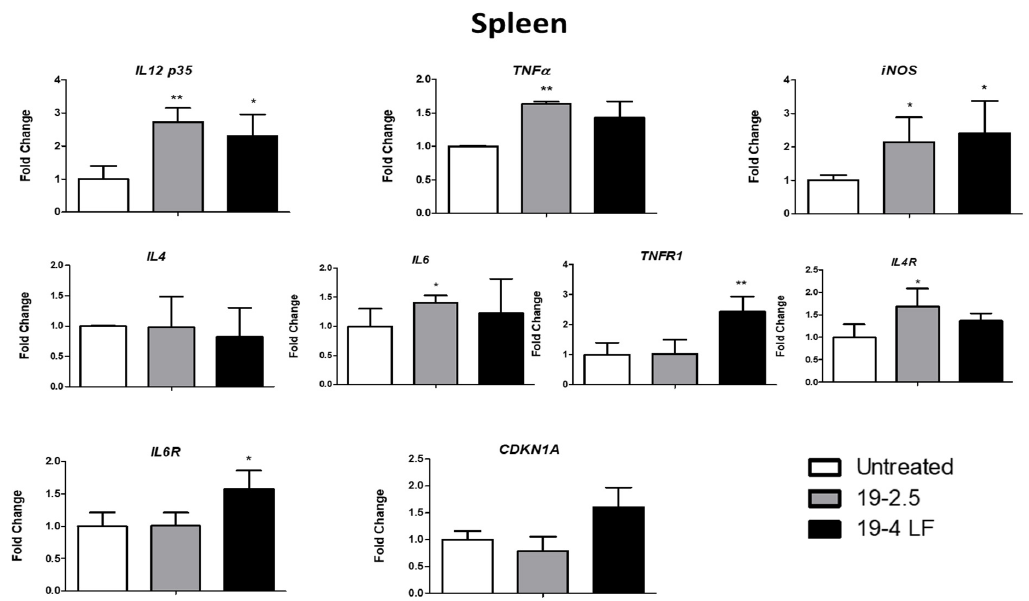
Figure 5. Gene expression levels of Th1 cytokines ( IL 12 p35 and TNF α ), iNOS gene, Th2 cytokines ( IL 4 and IL 6 ), cytokine receptors ( TNFR1 , IL4 R α and IL6 R ) and CDKN1A gene from the spleen of BALB/c mice treated with 19-2.5 and 19-4 LF peptides or untreated. β -actin was used as a housekeeping gene to normalize mouse gene expression. The amount of each transcript was expressed by the formula 2 ct (actin)- ct (gene) . Bars represent the means (±SD) (*, p < 0.05; **, p < 0.01). 3.5. P2X7 Receptor Gene Expression was Highly Reduced by Both Peptides in Skin Lesions of BALB/c Mice